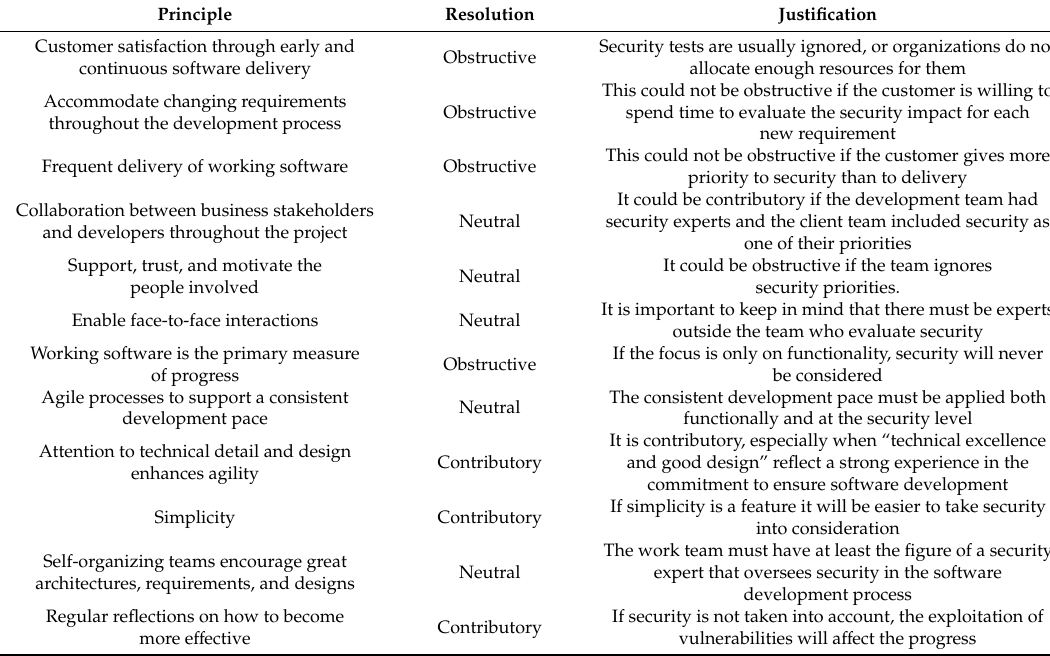
Table 3. Agile Manifesto principles